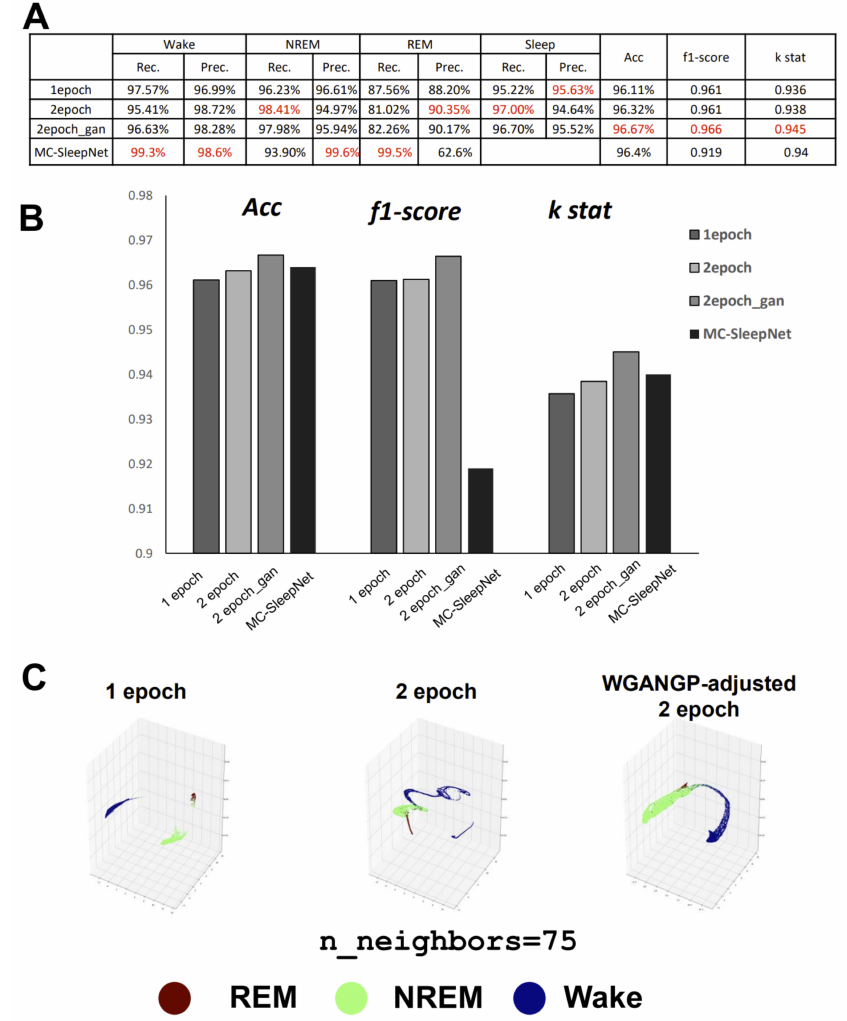
Figure 5. Performance of image-based sleep classification. ( A ) Scoring performance on Tsukuba-14 datasets compared with the original MC-SleepNet algorithm. Overall evaluation by three scales of accuracy, F1 score, and Cohen’s κ shows an improved performance with the additional one epoch and the assistance of the GAN-generated fake REM images. The scaled data of the MC-SleepNet are from the original work. The red font represents the highest performance in each column. Left side show the specific dataset we used for training ( B ) Comparison bar graph of three parameters between different algorithms. ( C ) Visualization of the dense layer of the model using the UMAP clustering algorithms. The different visible clustering separations display the scoring performance, particularly for the REM